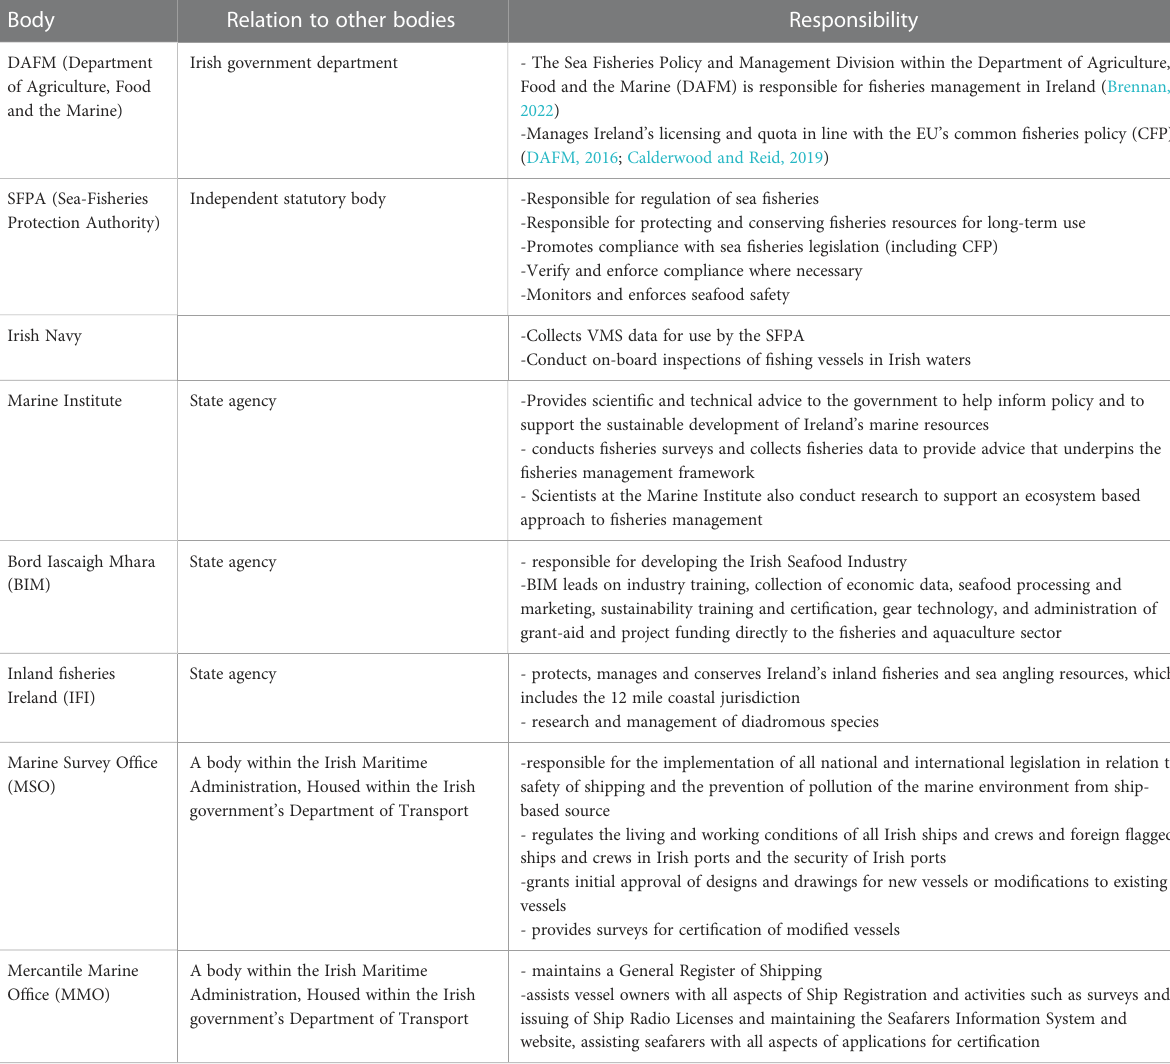
TABLE 1 Bodies and departments within Ireland that have responsibilities in relation to Irish fi sheries.